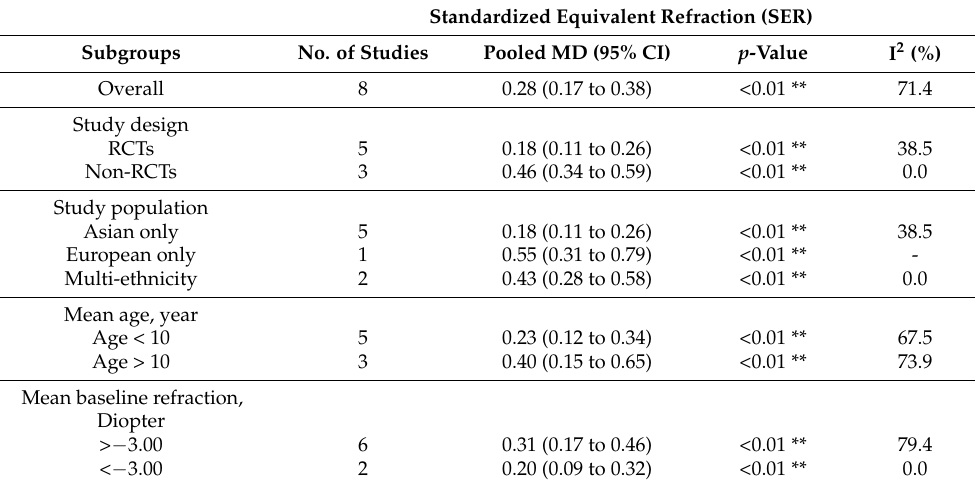
Table 2. Subgroup analyses of efficacy outcomes in standardized equivalent refraction.